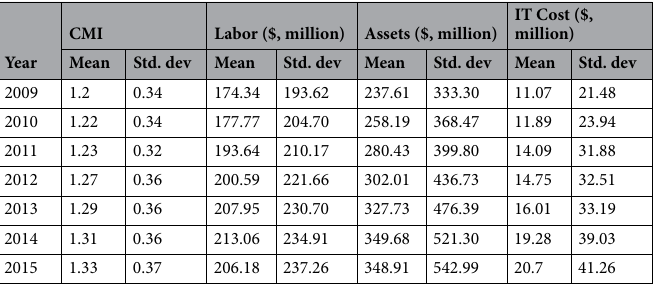
Table 2. Descriptive Statistics for financial variables across year (unit: hospital year).